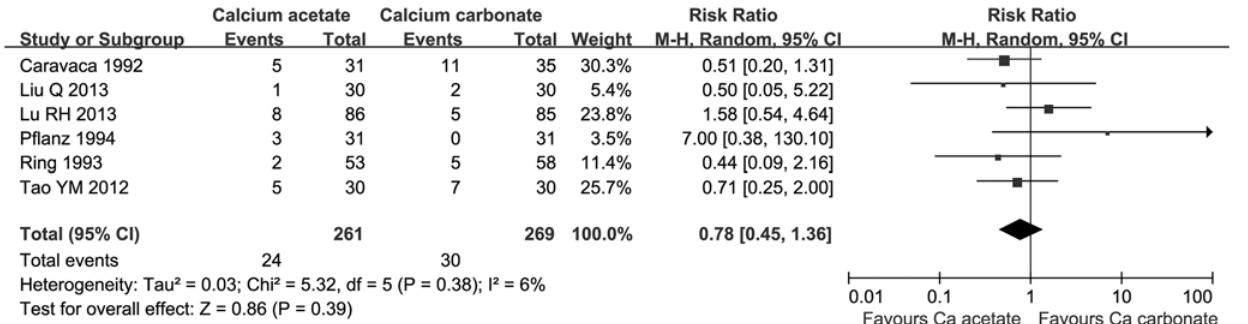
Fig 7. The incidence of hypercalcaemia in calcium-based phosphate binder groups.